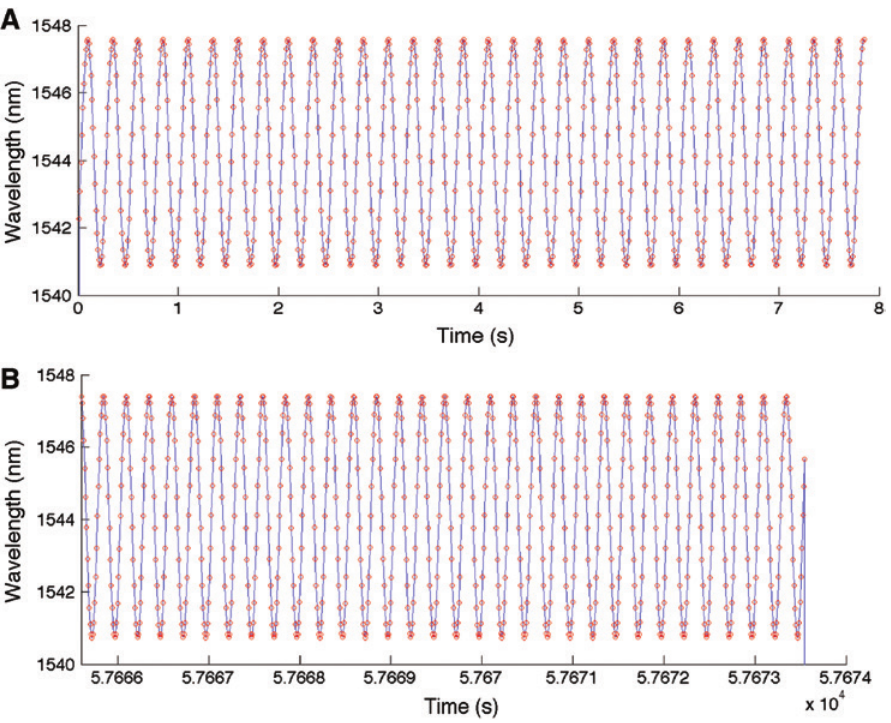
Figure 5: Cyclic variation of wavelength of 1-mm-long FBG: (A) initial 8 s and (B) final 8 s.